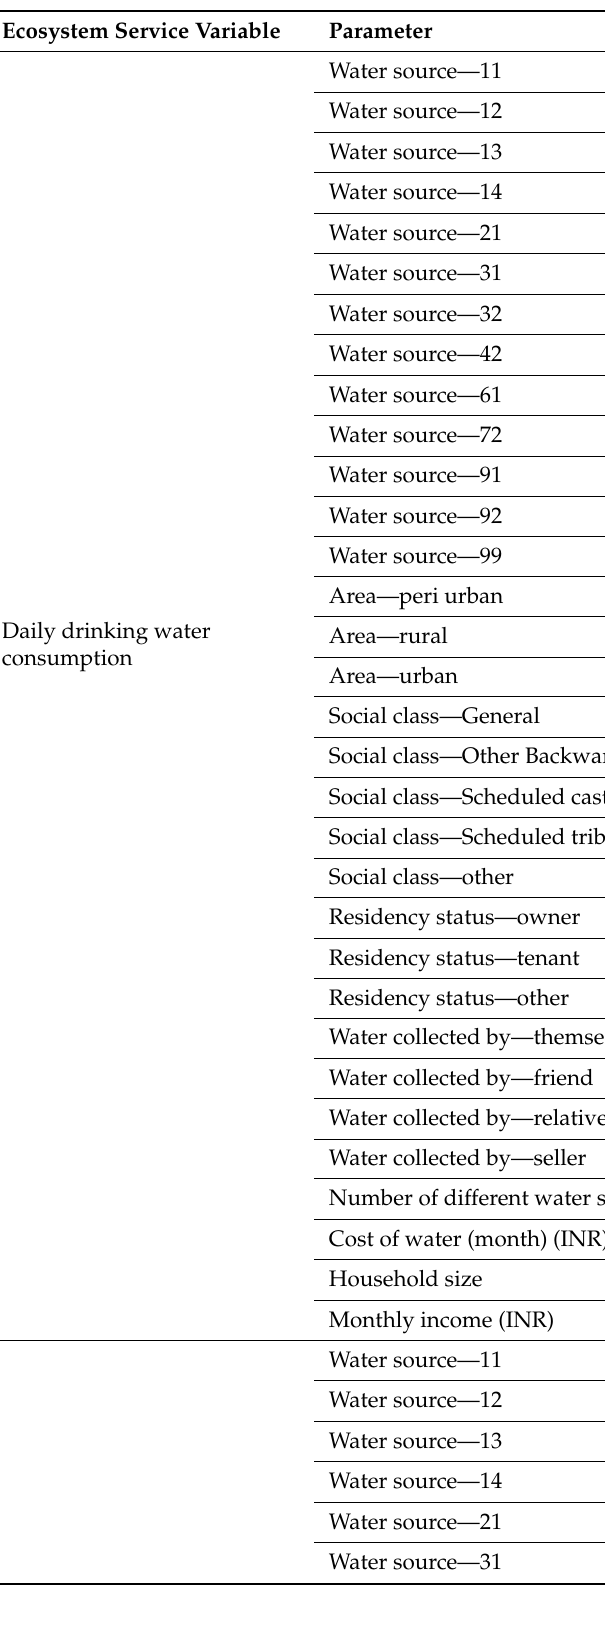
Table A5. Ecosystem service quantification (for variable descriptions see Appendix